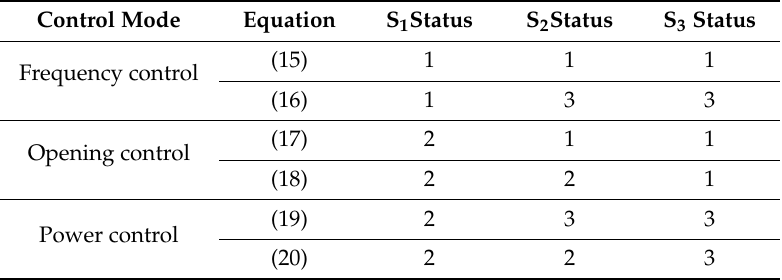
Table 3 is replaced with: Table 3. Status of selectors in different control